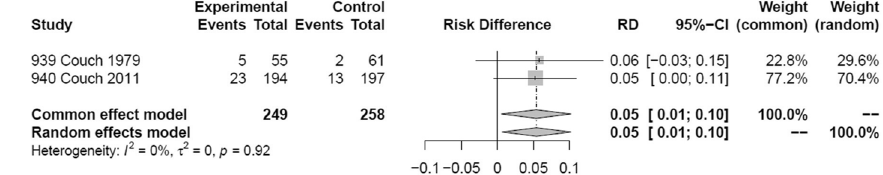
Fig. 7 Forest plot showing meta‑analysis comparing amitriptyline with placebo for adverse events leading to